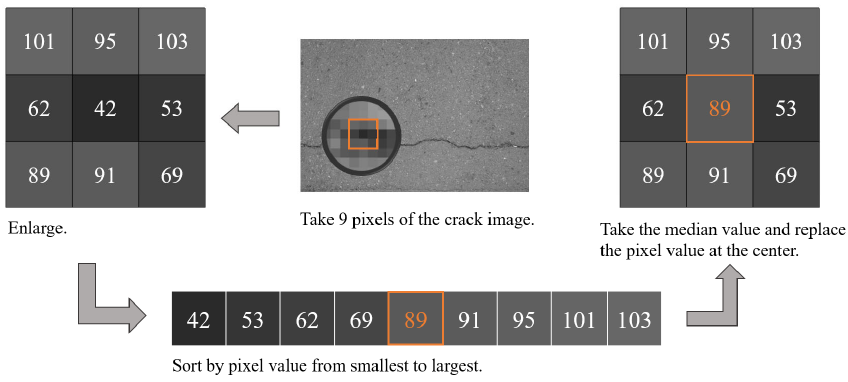
Figure 3. Pipeline of the 2nd algorithm.